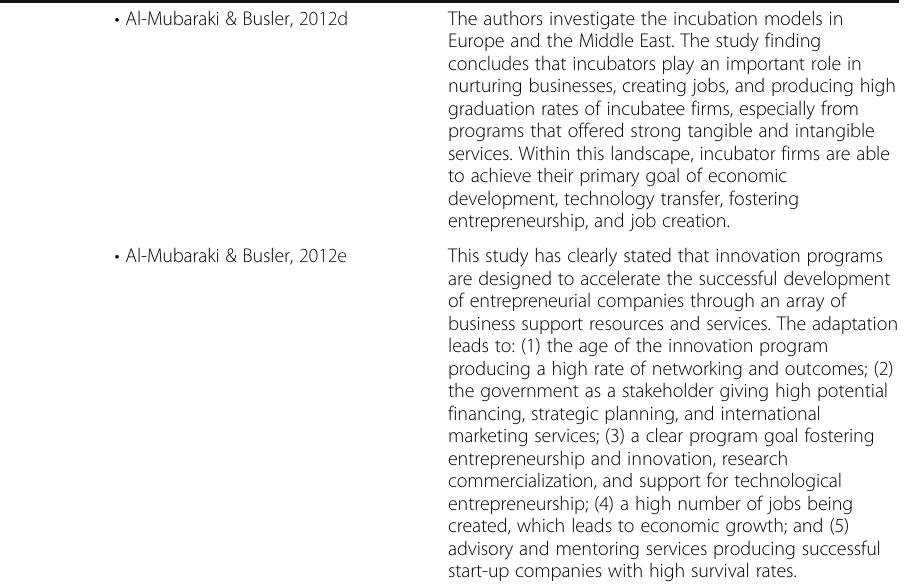
Table 1 Incubators: evidence from the literature